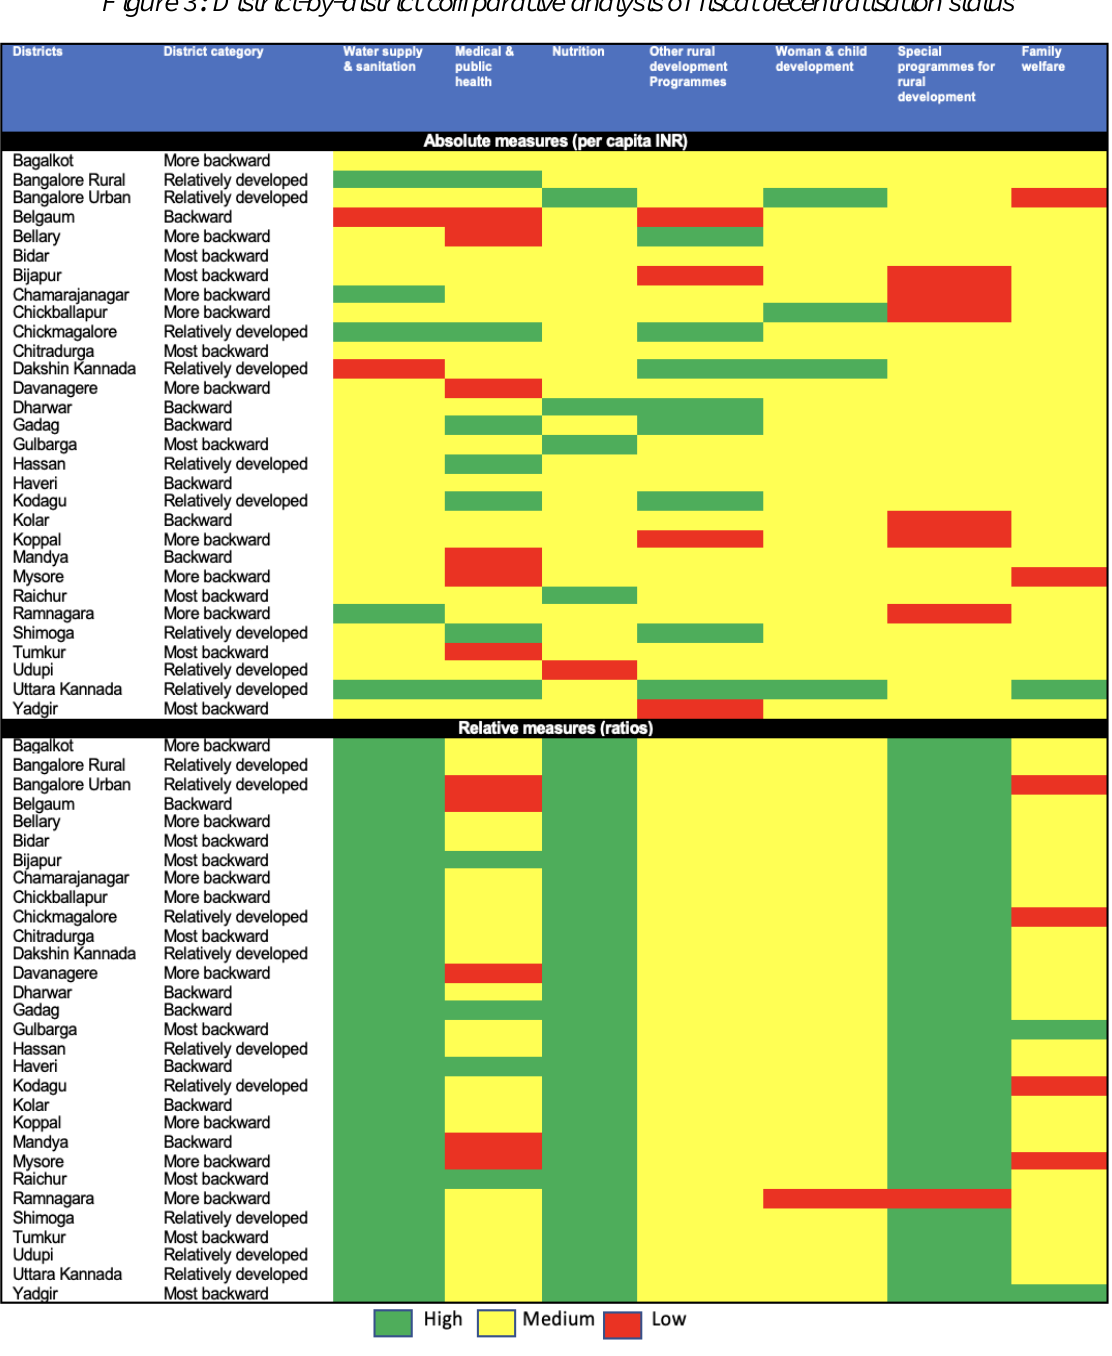
Figure 3: District-by-district comparative analysis of fiscal decentralisation